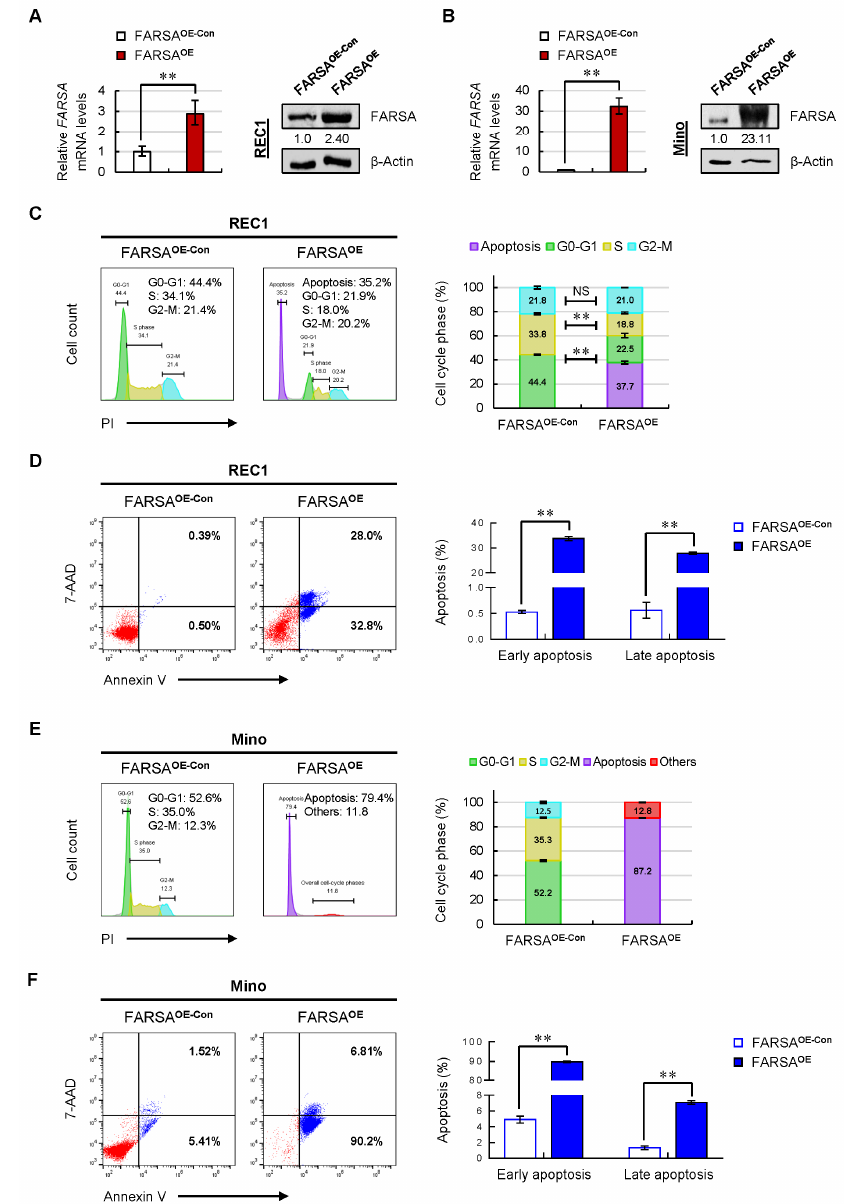
Figure 3. Overexpression of FARSA in REC1 and Mino cells induces remarkable cell-cycle arrest and overwhelming cell apoptosis. The overexpressed efficiency of FARSA in REC1 ( A ) and Mino ( B ) cells were validated using qRT-PCR ( left ) and immunoblotting ( right ), respectively. Each value from qRT-PCR was normalized to ACTB and is presented as the mean ± SD. β -Actin was used as a loading control for immunoblots with the normalized values (FARSA/ β -Actin) indicated under each lane. ( C ) Representative cell-cycle distribution of FARSA OE REC1 cells staining with PI ( left ). The % population of cells in each phase is shown as the mean ± SD from three independent experiments ( right ). ( D ) Representative cell apoptosis in FARSA OE REC1 cells staining with Annexin V/7-AAD ( left ). The % population of early- and late-apoptotic cells in each group is shown as the mean ± SD from three independent experiments ( right ). ( E ) Representative cell-cycle distribution of FARSA OE Mino cells staining with PI ( left ). The % population of cells in each phase is shown as the mean ± SD from three independent experiments ( right ). ( F ) Representative cell apoptosis in FARSA OE Mino cells staining with Annexin V/7-AAD ( left ). The % population of early- and late-apoptotic cells in each group is shown as the mean ± SD from three independent experiments ( right ). NS, not significant; ** p < 0.01 (vs. control